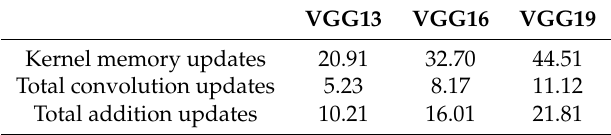
Table 3. The parameter update times (ms) of all convolution